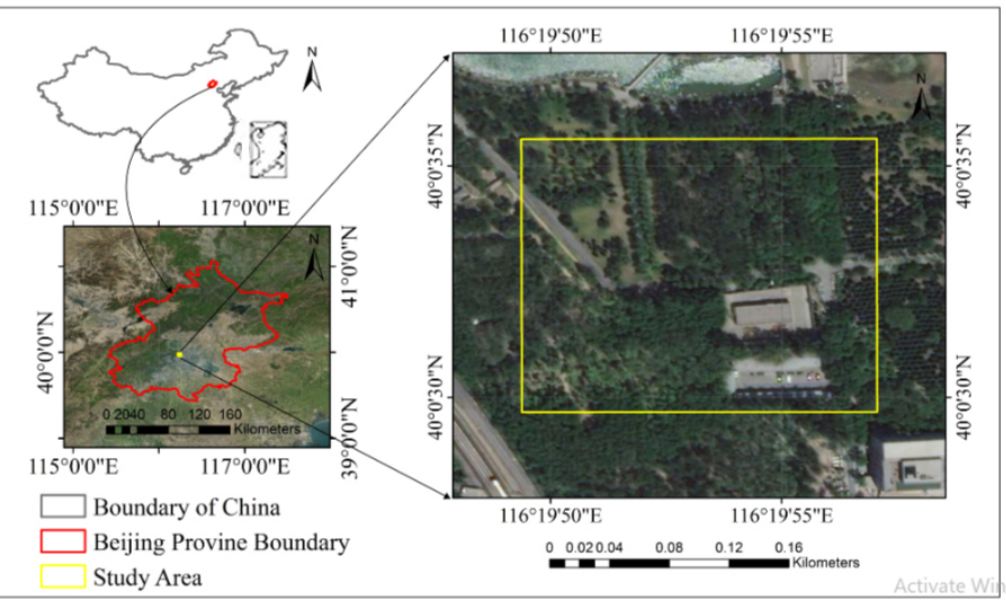
Figure 2. Study area location map.